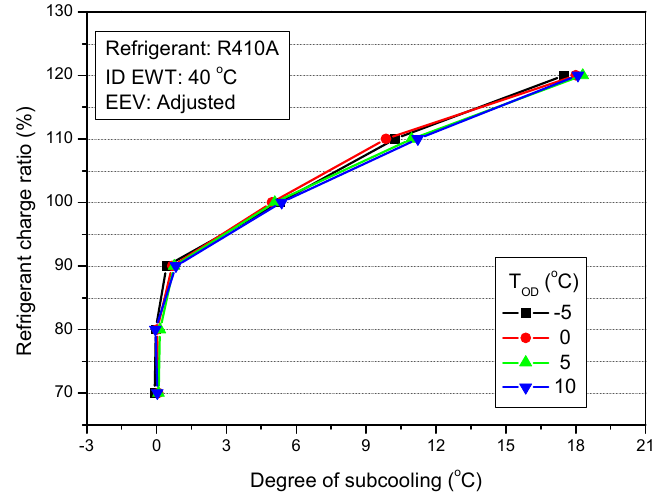
Figure 28. Relationship between refrigerant charge ratio and degree of subcooling in heating mode.